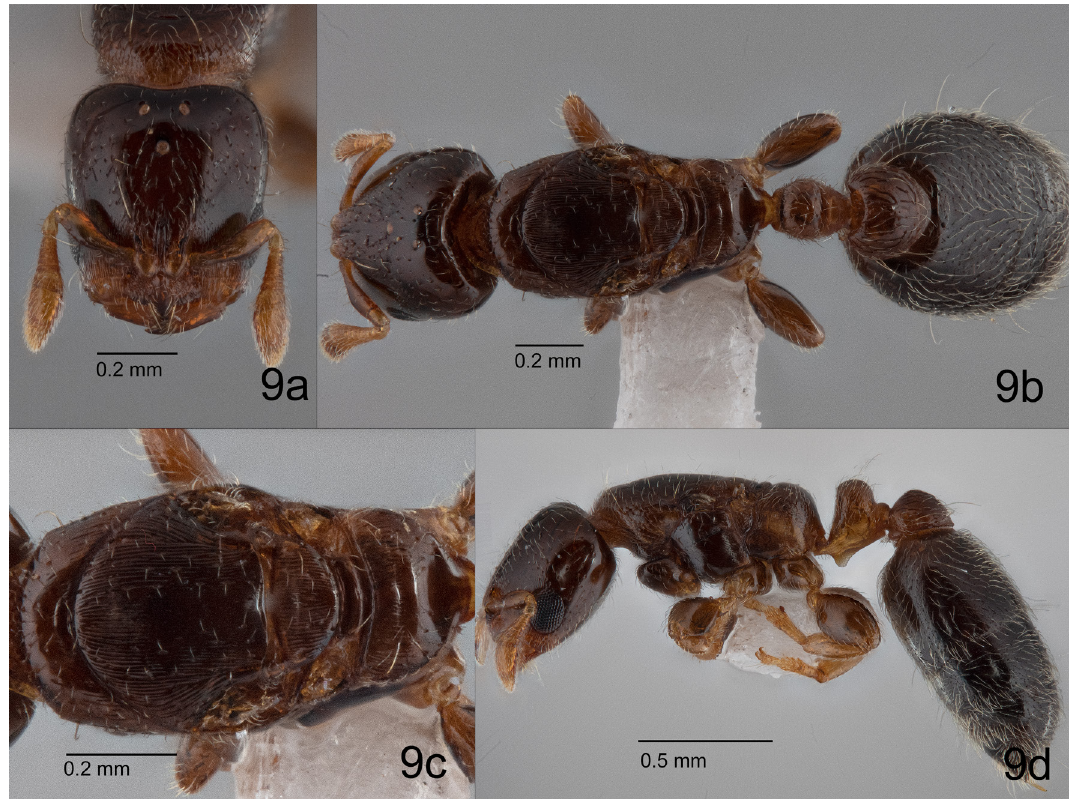
Fig. 9. Rhopalomastix johorensis Wheeler, 1929, non-type, queen, Central Thailand (ZRC_ ENT00013956). a . Head in full-face view. b . Body in dorsal view. c . Close-up of mesosoma in dorsal view. d . Body in lateral